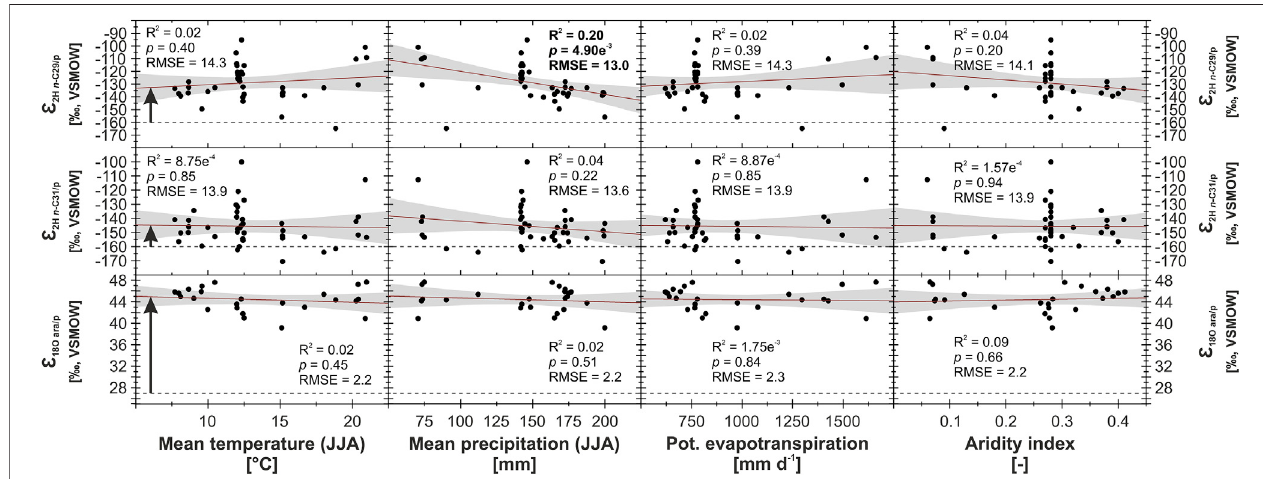
FIGURE 4 | Apparent fractionation Ɛ 2H n -C29/p , Ɛ 2H n -C31/p and Ɛ 18O ara/p from the topsoil transect through Mongolia plotted against T JJA , P JJA , Et 0 , AI (Fick and Hijmans, 2017; Trabucco and Zomer, 2019). Red trend lines illustrate linear regressions, gray shaded areas the 95% con fi dence interval. Bold R 2 / p -values indicate the levelofsigni fi cance( α (cid:1) 0.05).Blackdashed linesillustratevaluesforthebiosyntheticfractionation, and blackarrows indicatetheeffectofevapotranspirativeenrichment (biosynthetic fractionation factors of − 160 ‰ and +27 ‰ are assumed for the n-alkanes and arabinose,